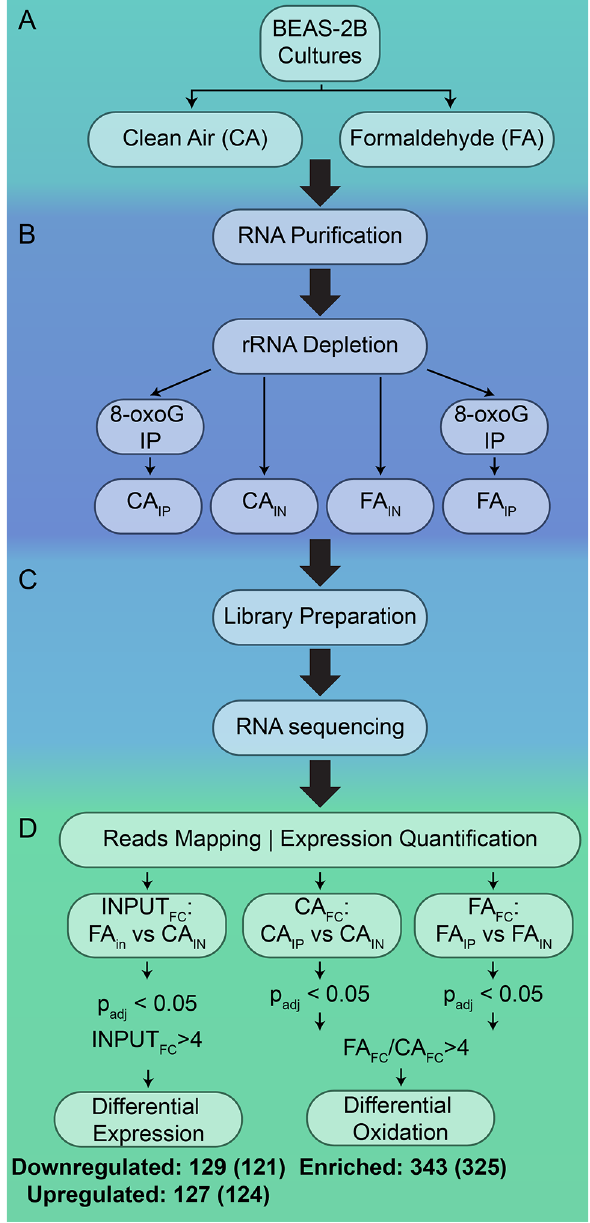
products identified by Enrichr corresponding to the transcript